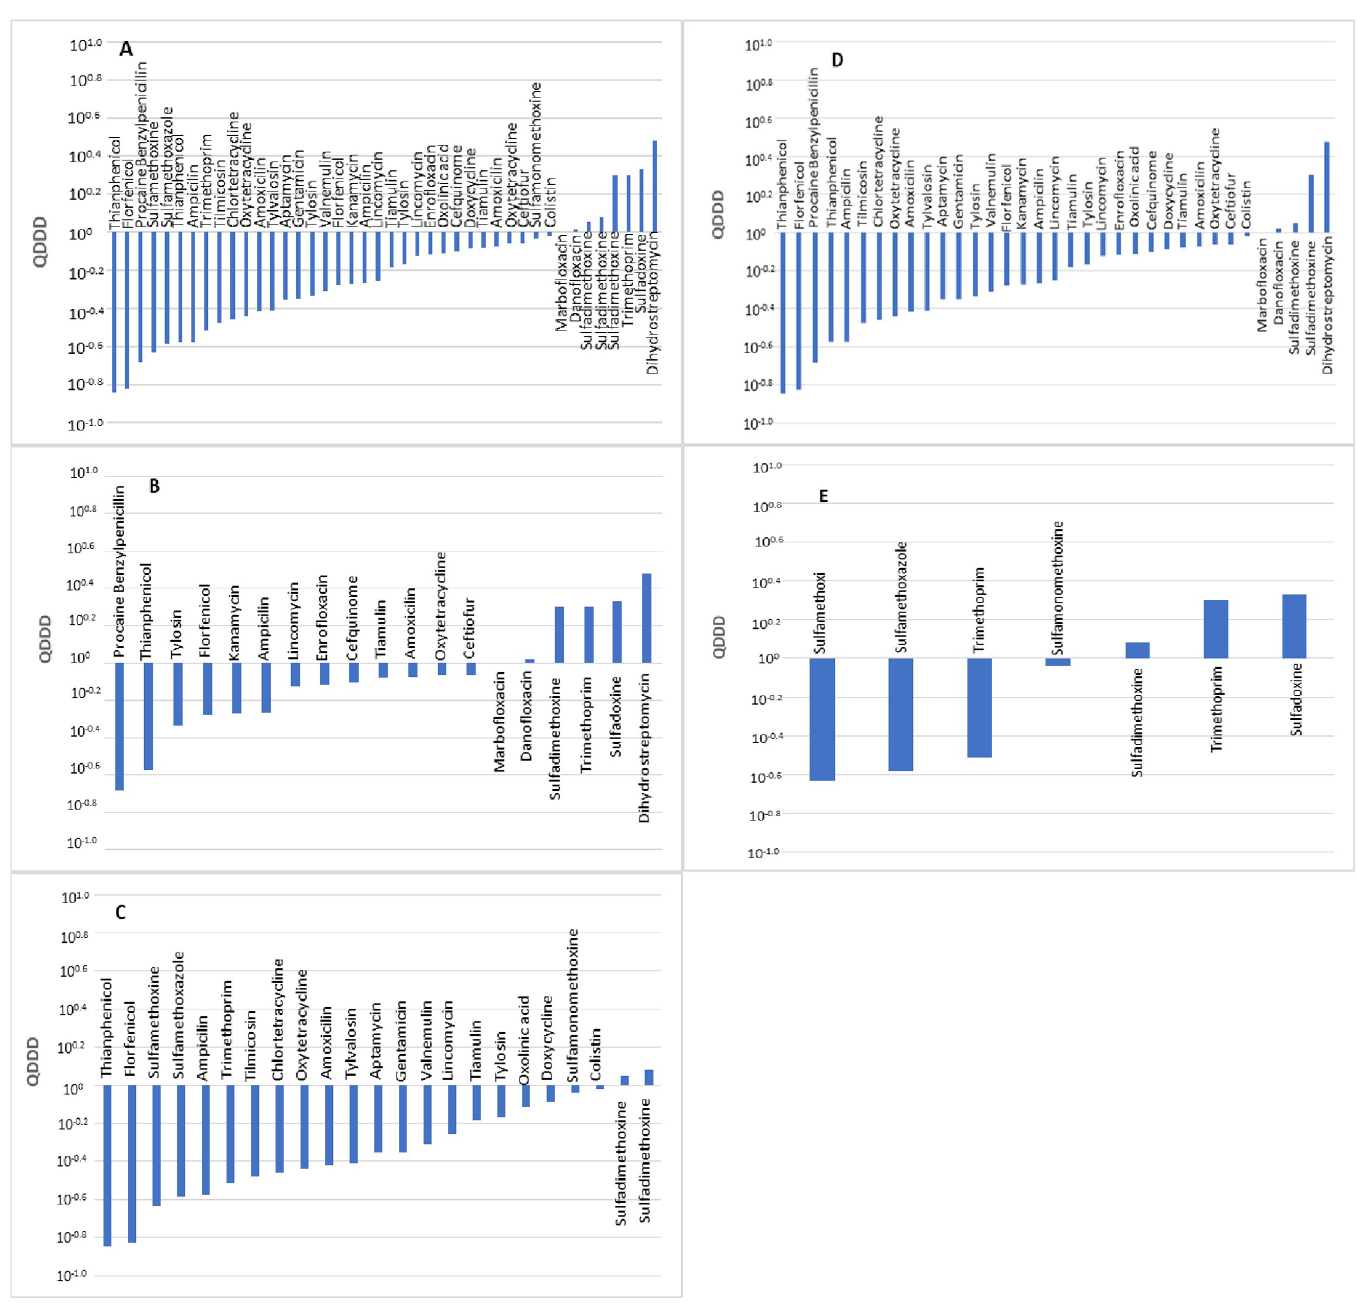
Fig 1. Comparison of the defined daily doses in Japan (DDDjp) of antimicrobial agents approved for use in pigs with the corresponding values of the European Medicines Agency (DDDvet). Bars indicate an antimicrobial agent for which both DDDjp and European values of DDD (DDDvet) values are available with QDDD (DDDjp/DDDvet) values in ascending order. Comparison of all antimicrobials (A), antimicrobial agents for injection (B), antimicrobial agents for oral administration (C), antimicrobial agent used in single substances (D) and antimicrobial agents used in combination products (E).